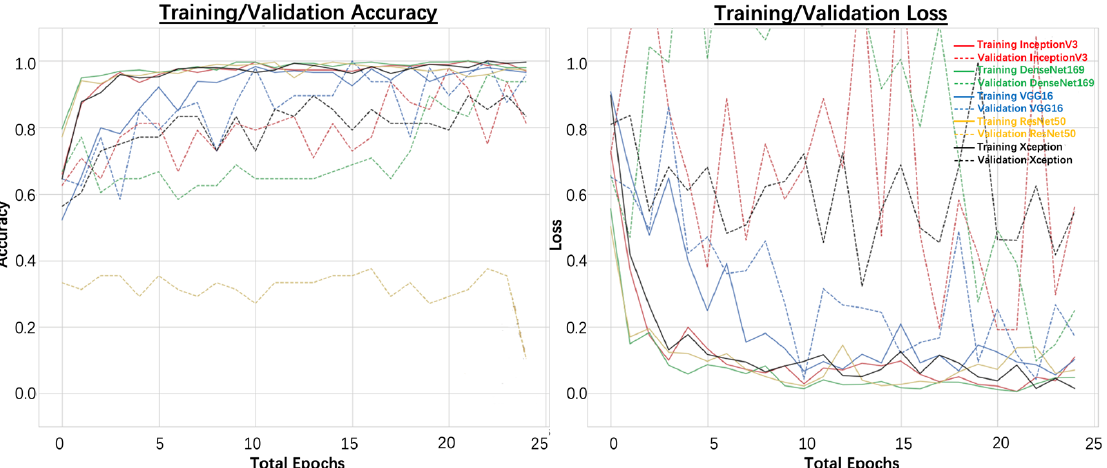
Figure 8. Training and validation accuracy and loss plots for training deep learning models to identify diseased regions using SLIC segments with a compactness (m) value of 10.